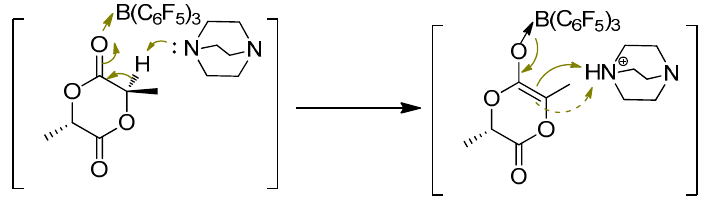
Scheme 16. Proposed mechanism for the epimerization of meso